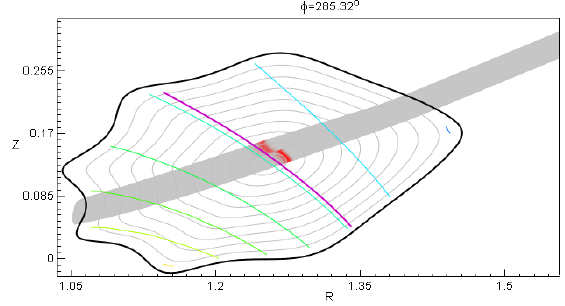
Fig. 1. Poloidal cross-section of Heliotron J at the CECE viewing location. The trajectory of 70 GHz EC waves is calculated using the TRAVIS